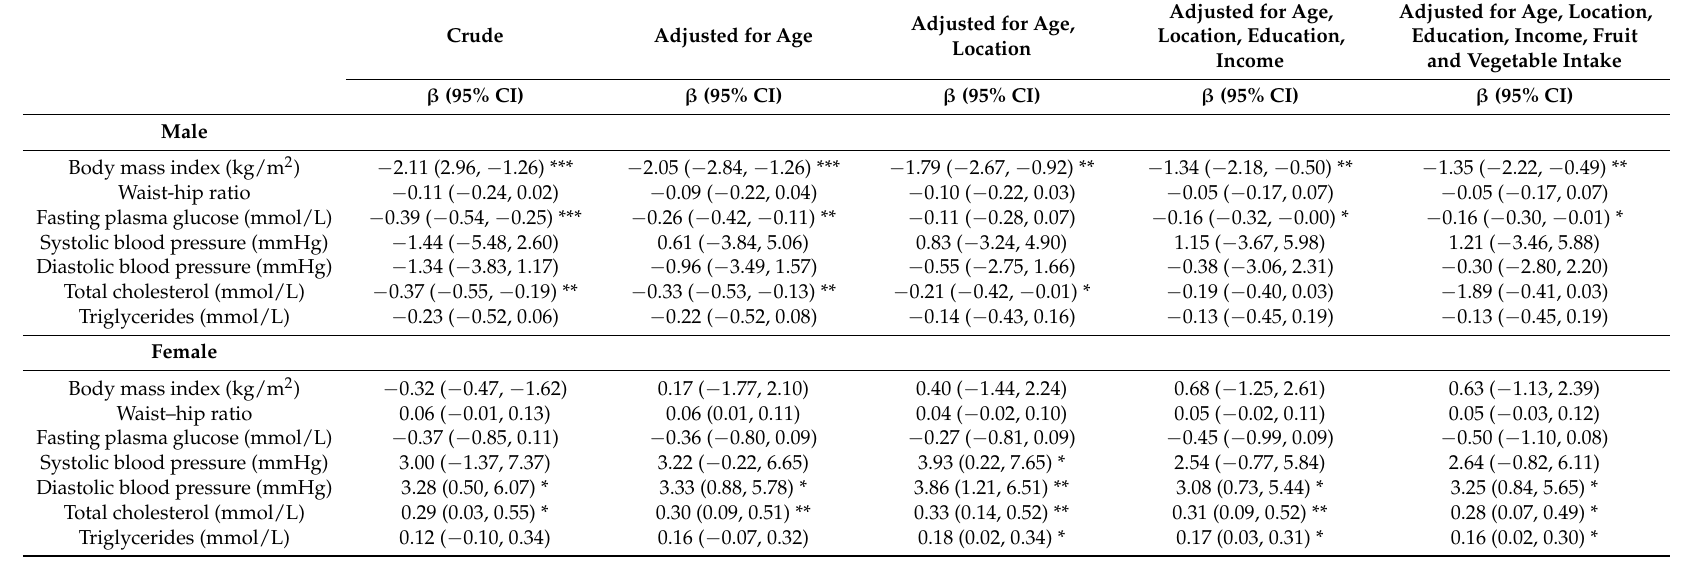
Table 3. The association between using palm oil in cooking compared to peanut oil, and various risk factors for non-communicable diseases, among 25–74-year-old citizens in the Yangon region between 2013–2014, and linear regression analysis.